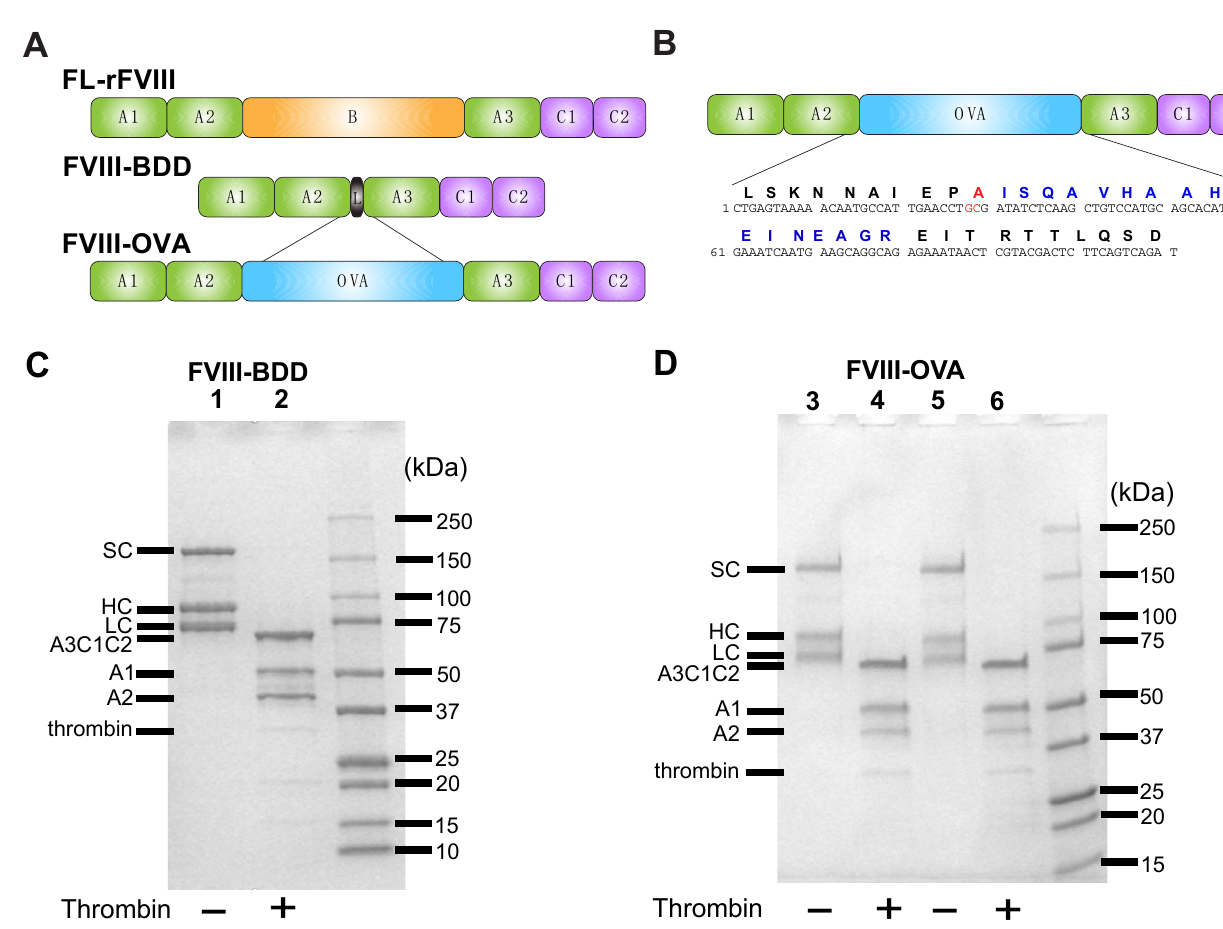
Figure 1. FVIII-OVA design and cleavage by thrombin. ( A ) Representative diagram showing FL- rFVIII, B-domain deleted (BDD) FVIII and the insertion of ovalbumin (OVA) peptide into the B- domain of BDD-FVIII. A1, A2, A3, B, C1 and C2 = FVIII domains. L = linker peptide. OVA = OVA peptide 323–339. ( B ) Insertion site of R740A mutation (red), followed by OVA consensus sequence (blue). SDS-PAGE analysis of ( C ) BDD-FVIII and ( D ) FVIII-OVA (shown in duplicate). Purified rFVIII or FVIII-OVA protein was resolved by 9% SDS-PAGE under reducing conditions and visualized by Coomassie blue staining. BDD-FVIII (lanes 1,2) and FVIII-OVA (lanes 3–6) were treated with or without thrombin prior to SDS-PAGE. Polypeptides were identified as labeled: single chain (SC), heterodimeric heavy chain (HC), light chain (LC), light chain (A3-C1-C2) and thrombin-cleaved A1 and A2 fragments.